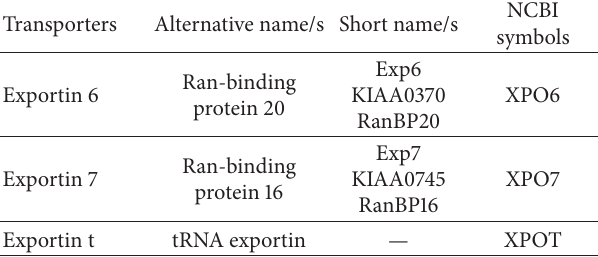
Table 1: Names and symbols of human importins and